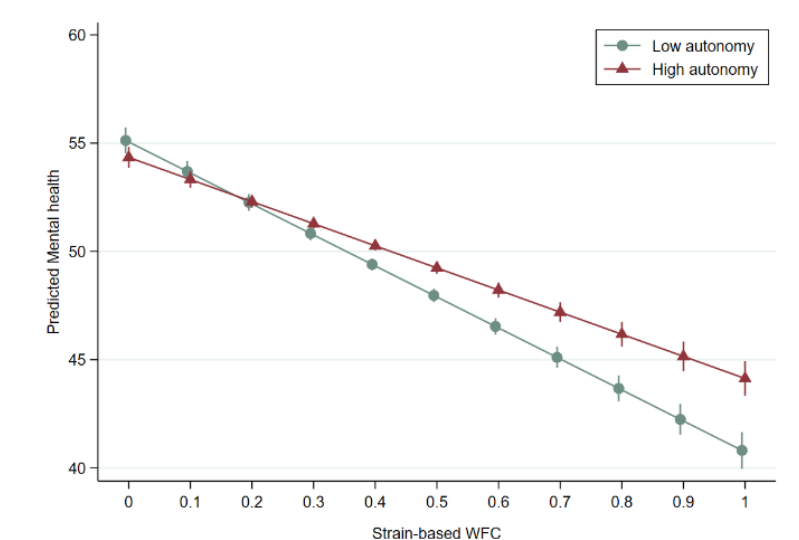
Interaction plots for time-based WFC#support from co-workers